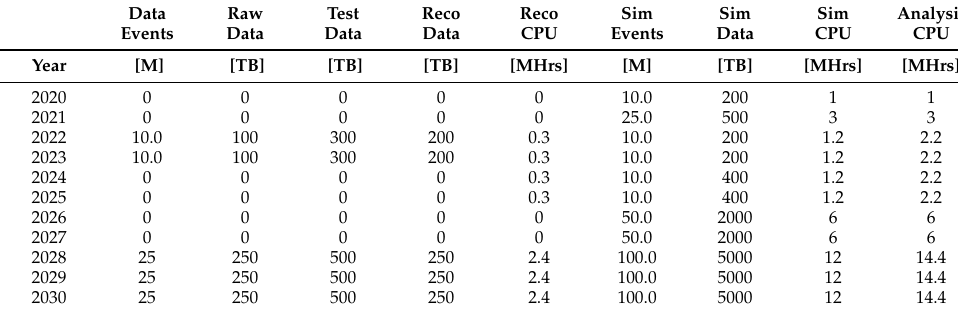
Table 31. Near detector computing resource estimates for CY 2020 through